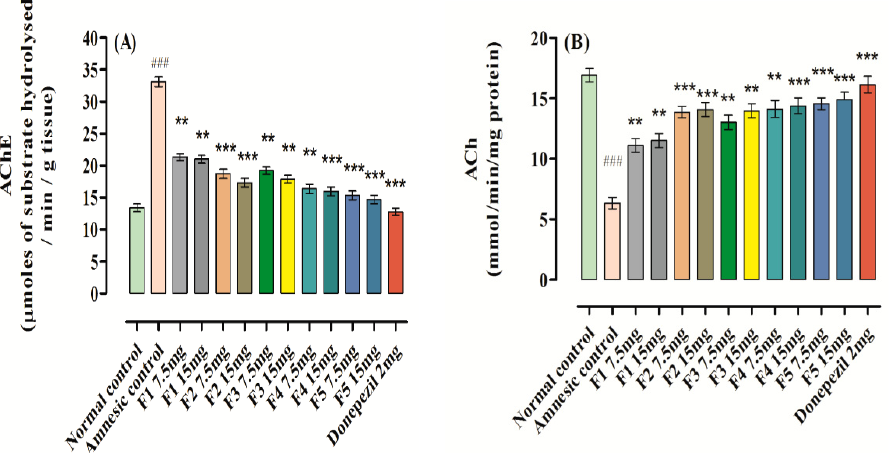
Figure 7. Effect of F1 – F5 on ( A ) AChE activity and ( B ) ACh level. Mean ± SEM ( n = 8). Statistically analyzed with one-way ANOVA followed by Dunnett’s post hoc multiple comparison test to determine the values of p . ### p < 0.001 comparison of amnesic (scopolamine) group vs. normal control. ** p < 0.01 and *** p < 0.001 as comparison of F1 – F5 treated groups, donepezil-treated group vs . amnesic group (scopolamine) using one-way ANOVA followed by Dunnett’s comparison.